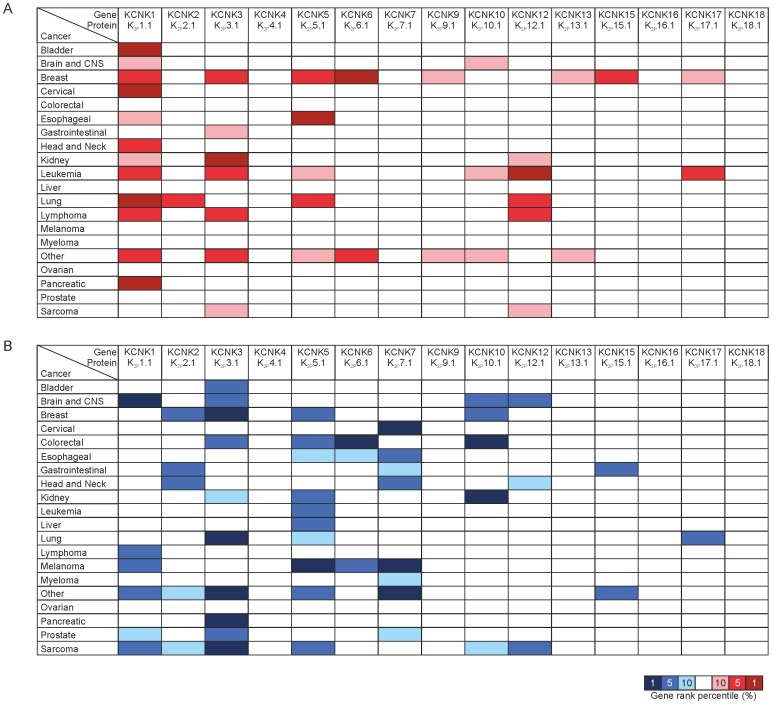
Expression of KCNK genes across different cancers.Expression of KCNK genes (KCNK1–18) in 20 cancers compared to normal tissue controls. Shown is the gene and protein names for each channel. A) overexpression of KCNK genes. B) underexpression of KCNK genes. Cancer types are organised by their tissue of origin, the degree of colour correlates to the gene rank percentile of the highest ranking analyses. Search criteria were for mRNA datasets and cancer vs. normal analysis only, with threshold values of p-value<0.05, fold change >2 and gene rank percentile <10%.